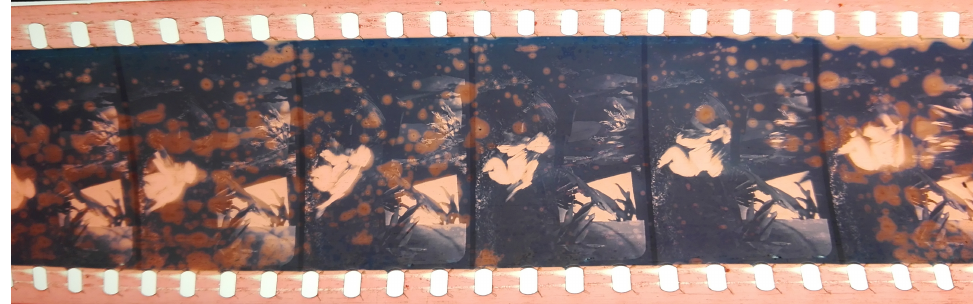
Figure 1: Waxworks chemical